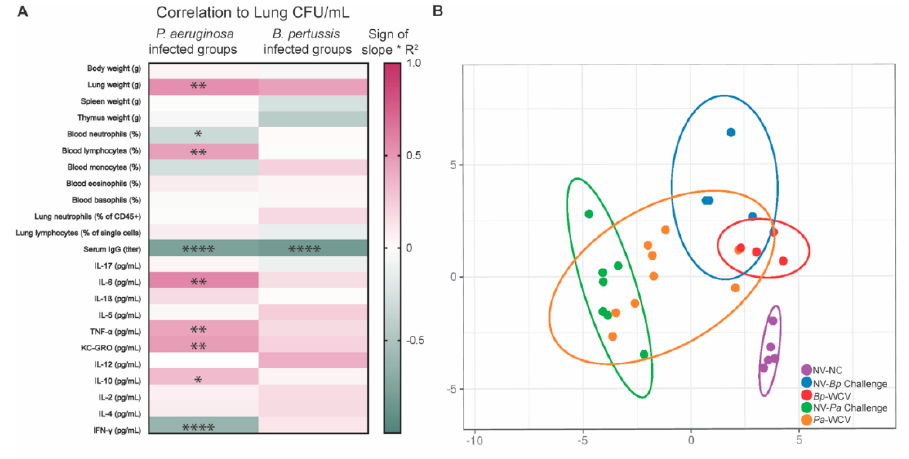
Figure 8. Measurement of correlates of protection. ( A ). Correlation of bacterial burden with measured immune components after challenge with B. pertussis or P. aeruginosa ( n = 4 per group). The R 2 and p values were calculated using linear regression analysis. A higher absolute value of R 2 indicates that the factor was strongly correlated with the bacterial burden. Positive slope (pink) indicates that an increase in that factor was associated with higher bacterial loads, whereas a negative slope (green) shows that the increase in that factor was associated with reduced bacterial burden. Asterisks overlaying the heatmap indicate linear regression analysis result: * p ≤ 0.05, ** p ≤ 0.01, **** p ≤ 0.0001. ( B ). Principal component analysis of measured immune components, with experimental groups shown by color. Purple is adjuvant-vaccinated non-challenged, blue is adjuvant-vaccinated, B. pertussis challenged, red is Bp- WCV, green is adjuvant-vaccinated, P. aeruginosa challenged, and orange is Pa- WCV.